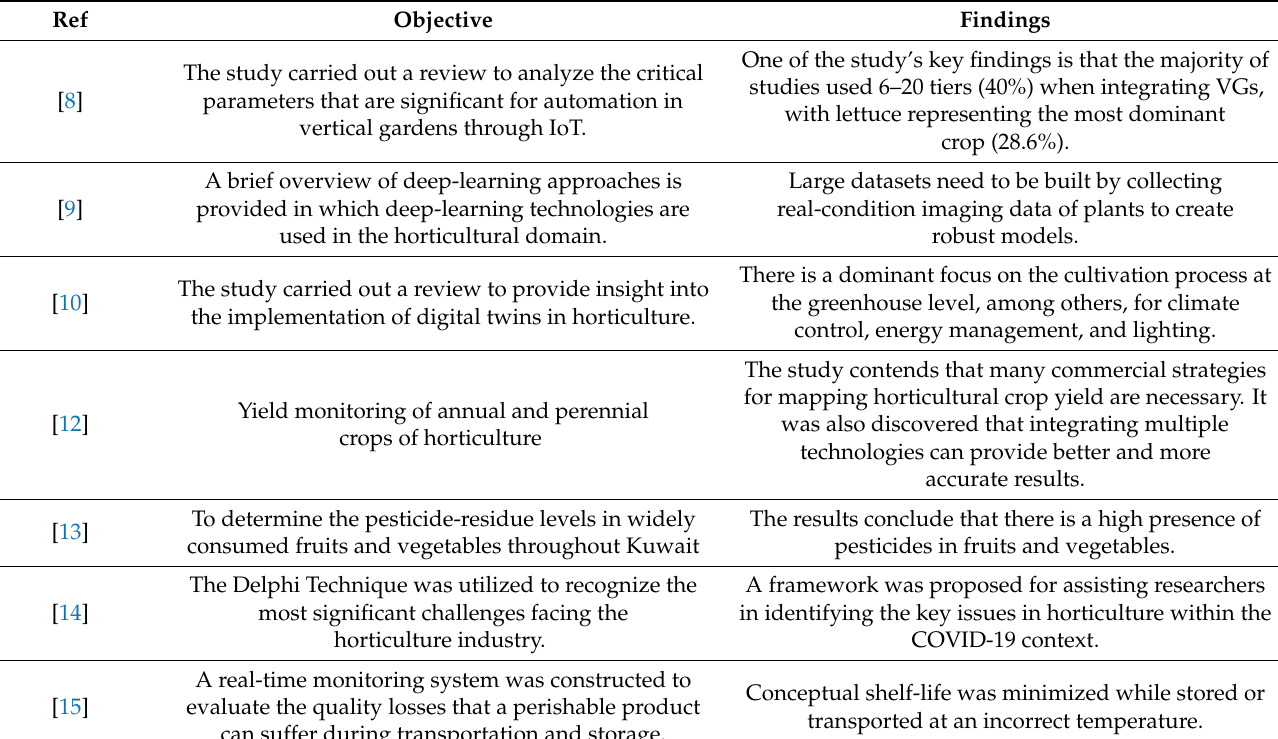
Table 1. Comparative analysis of the previous studies with the current